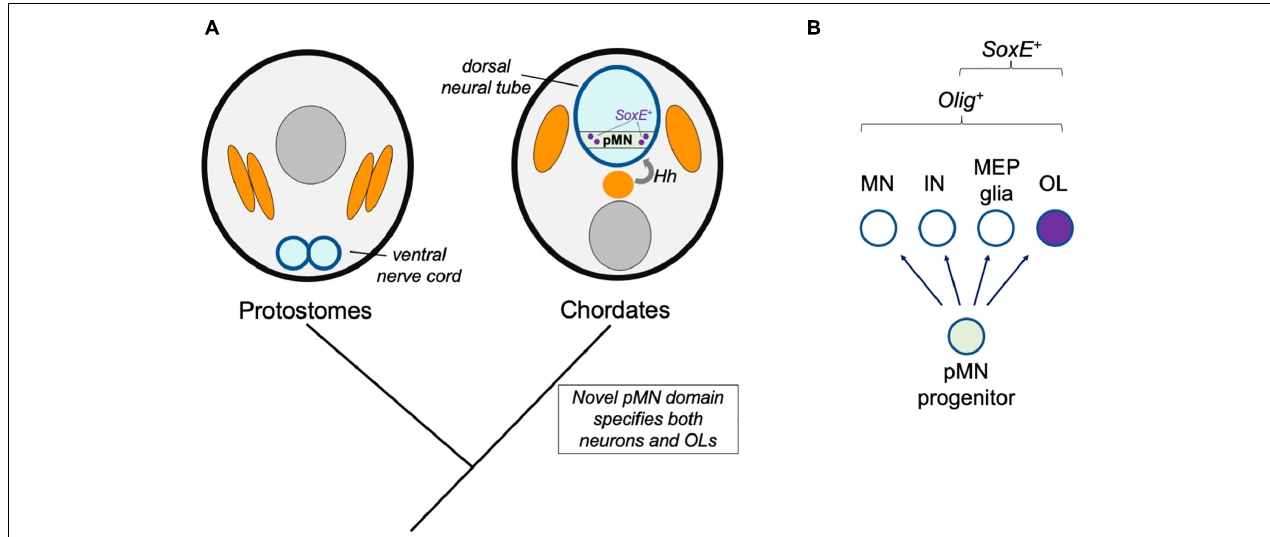
FIGURE 2 | Novel progenitor zone model. (A) Hypothetical model for the origins of the oligodendrocyte cell type in ancestral chordates. Whereas protostomes possess a ventral nerve cord, the emergence of the dorsal neural tube and Hedgehog (Hh)-dependent patterning of neural tube progenitor zones corresponded to the emergence of the pMN domain (green) and its derivatives, including oligodendrocytes (OL). (B) This model predicts that all species with pMN progenitors produce a subset of derivatives that express oligodendrocyte core GRN factors including Olig and SoxE-family